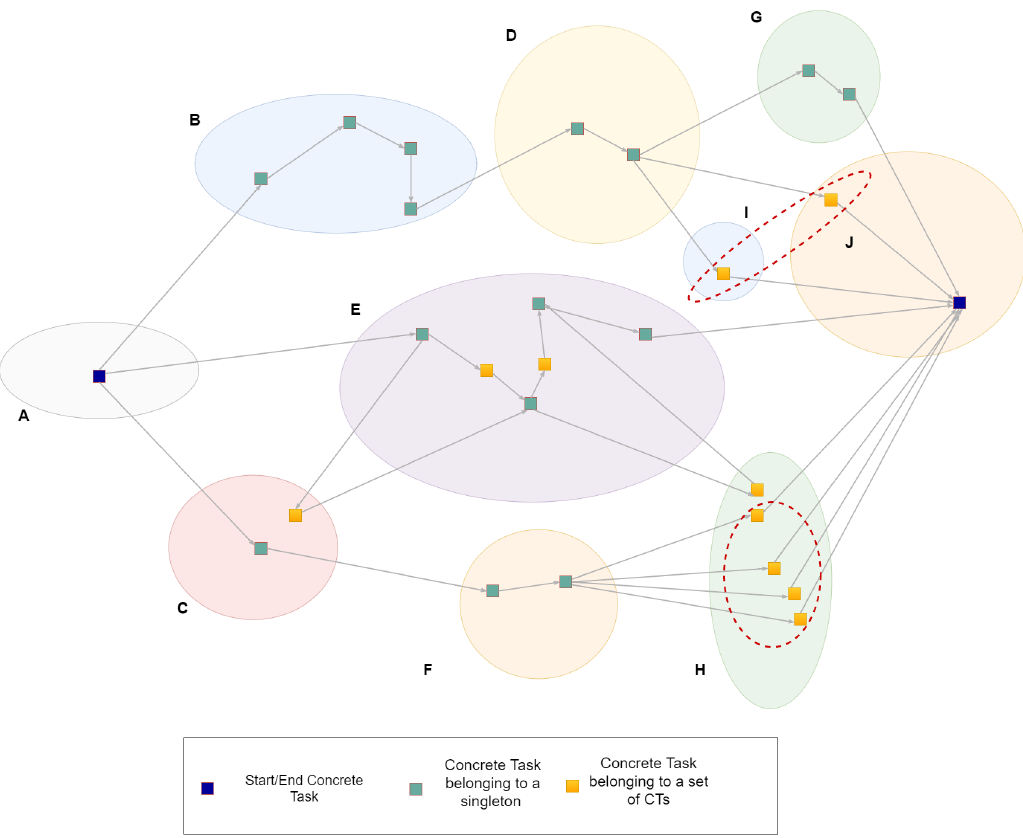
Figure 10. Concrete